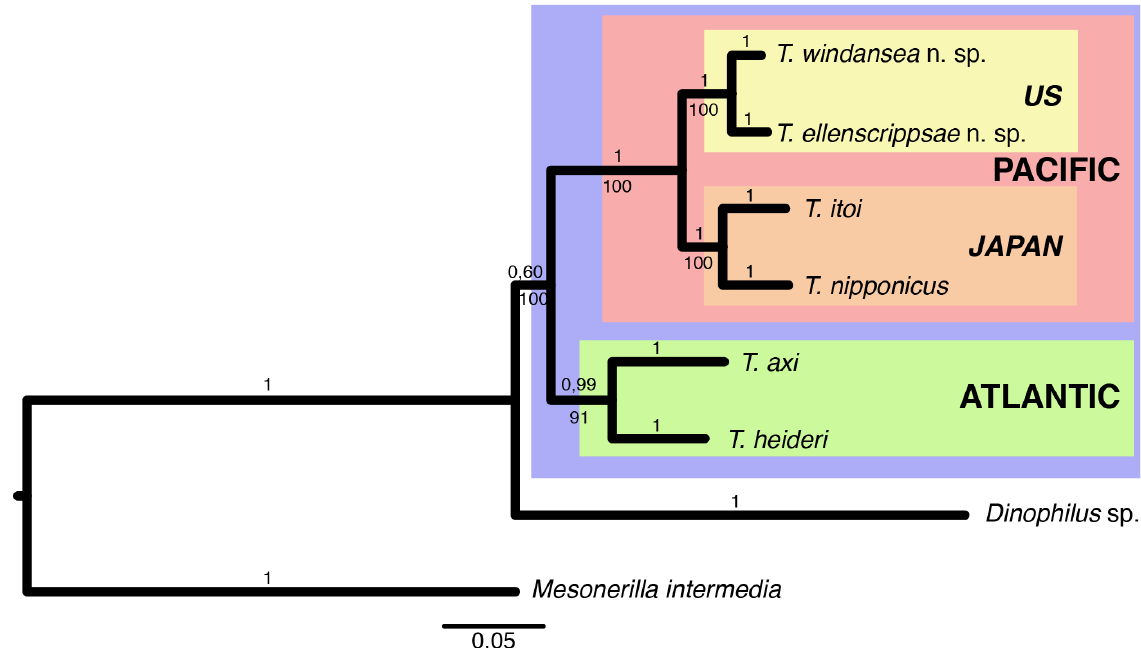
Fig. 2. Phylogenetic tree resulting from Bayesian analysis based on combined COI, 18S, and 28S rRNA gene sequences of already known and sequenced species and the newly described species of Trilobodrilus Remane, 1925. Numbers above nodes indicate maximum-likelihood bootstrap support values in percent ( > 60%), and numbers below nodes indicate posterior probabilities from Bayesian inference ( > 0.90), respectively. The yellow box labels the two species from the West Coast of the USA, the orange box the species from Japan, which are collectively labelled by the red box as Pacific species. The green box labels species recorded from the Atlantic, and all these species form the clade Trilobodrilus (violet